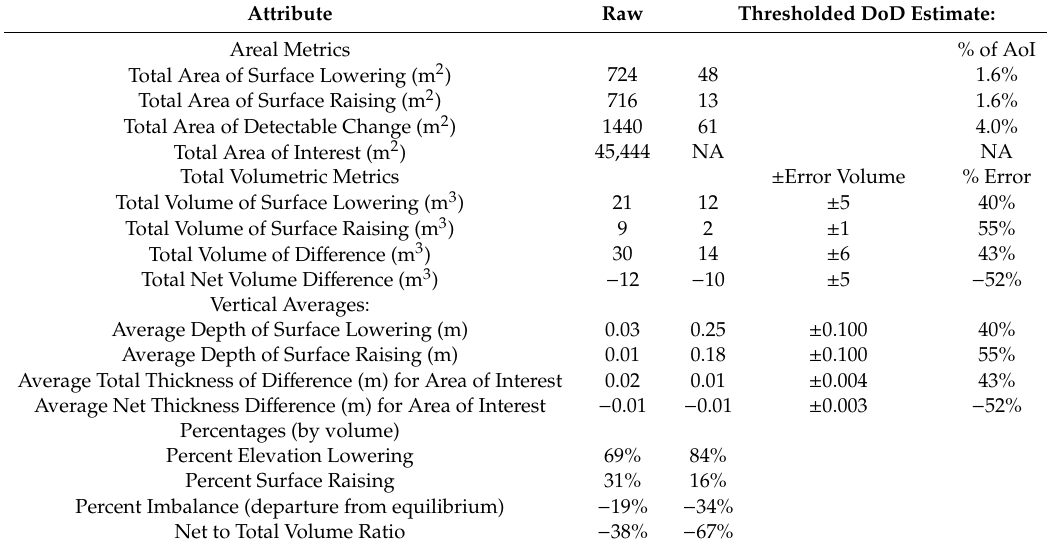
Table 2. Changes in physical parameters of the Area of Interest in July 2010 calculated volumetrically with reference to the total volume of the gravel-cobble material’s net change recorded by the DoD (both lowering and raising) from the manually cleaned-up (new) to the CSF-filtered (old) DTM. The uncertainty analysis was calculated by simply using the minimum level of detection (minLoD) approach while accounting for a uniform error of 0.1